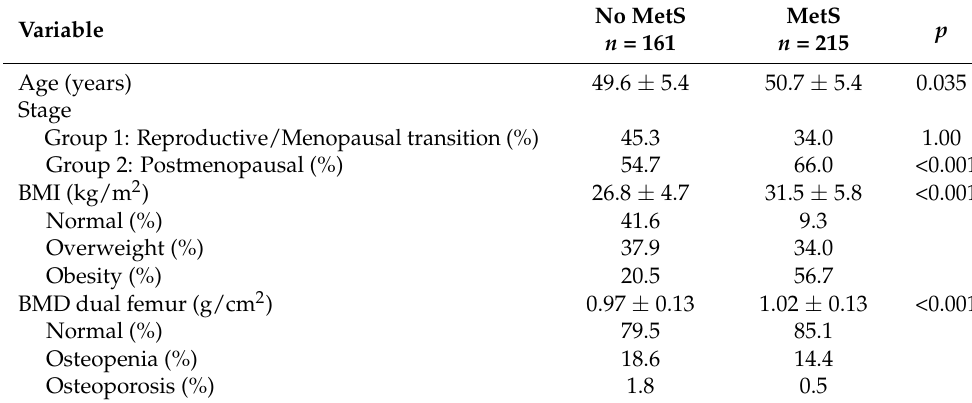
Table 1. Characteristics of 40–60-year-old women of Nuevo Leon State,